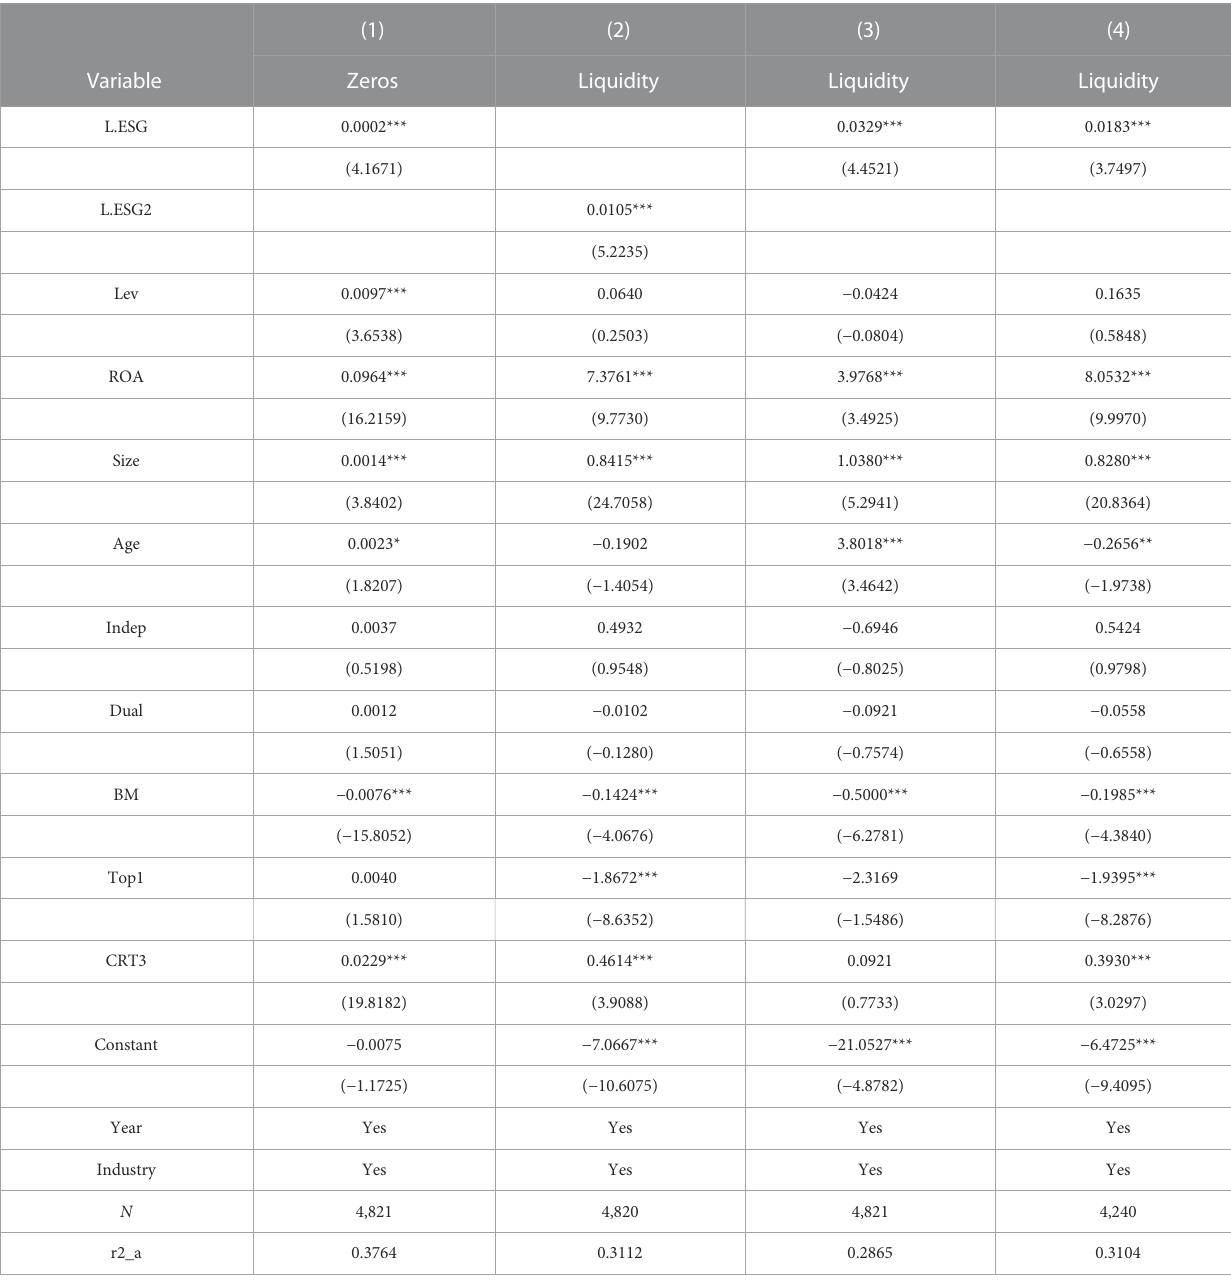
TABLE 5 Robustness